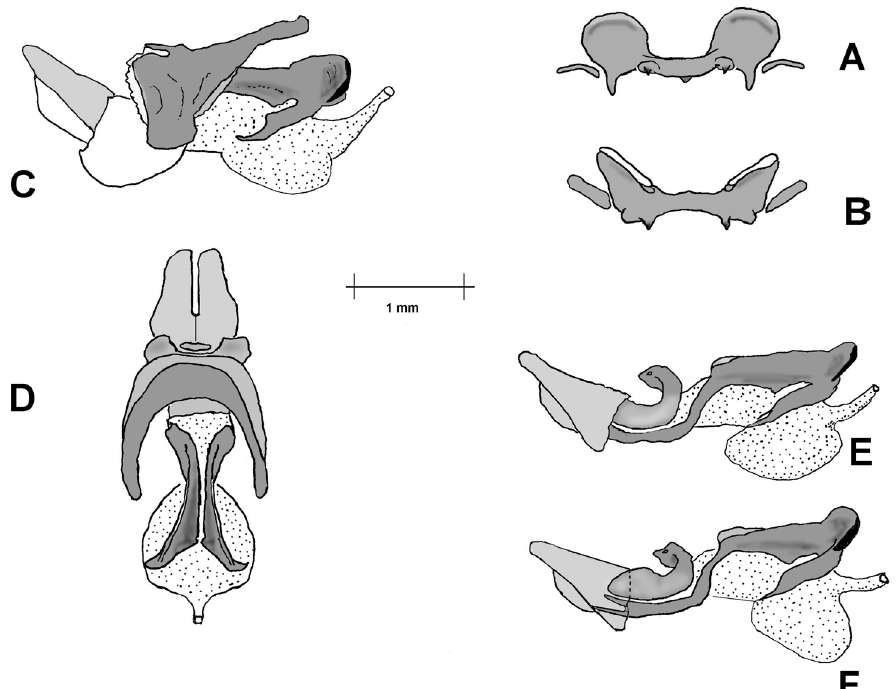
Fig. 6. Aresceutica lemarineli , comb. n., phallus. A. Epiphallus, axial view; B. Epiphallus, dorsal view; C. Phallic complex in lateral view, with epiphallus and epiphallic membrane removed; D. As in C, but dorsal view; E. Endophallus and arch, lateral view; F. As in E, but course of dorsal and ventral aedeagal valves inside the aedeagal sheath